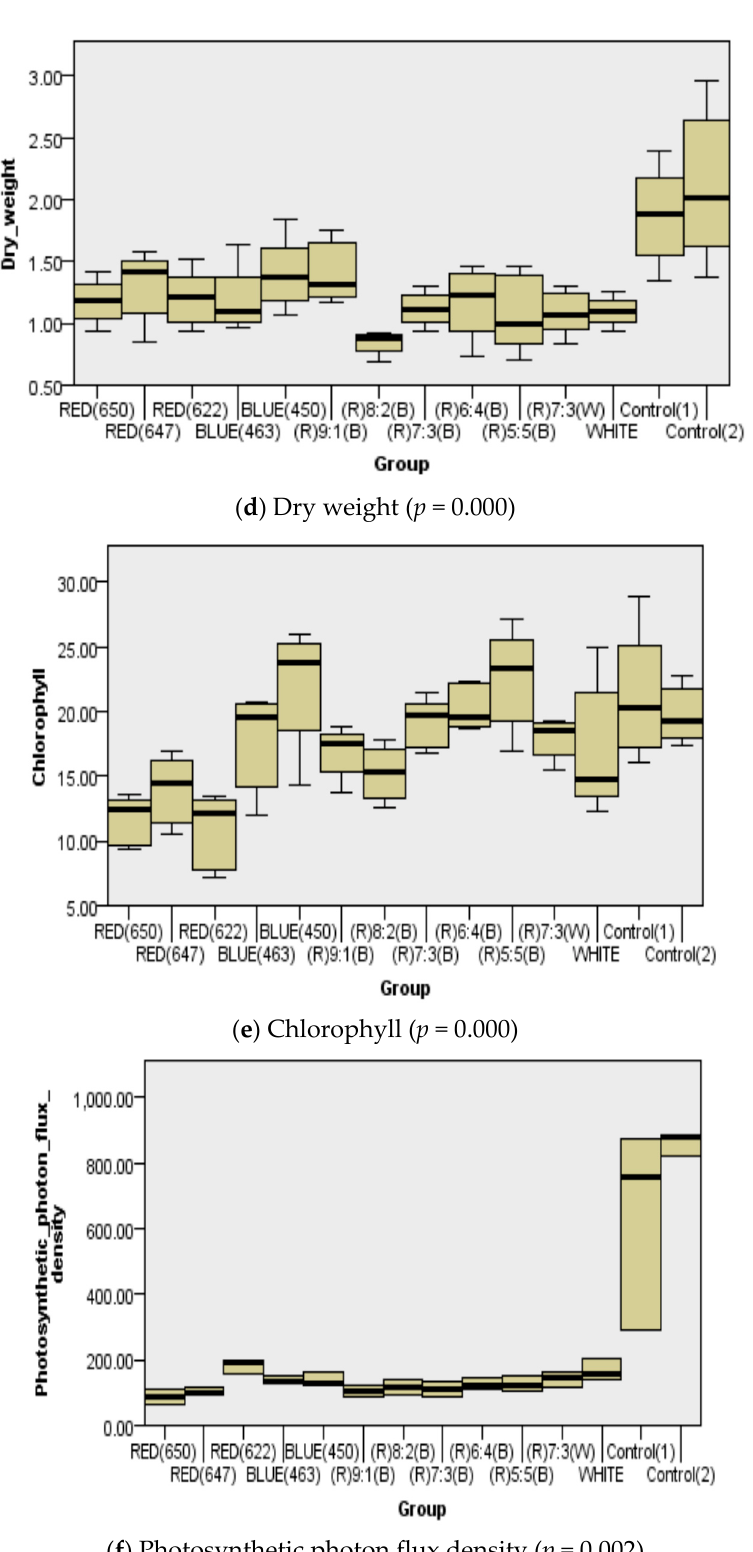
Figure 18. The analysis data for the plant factory.